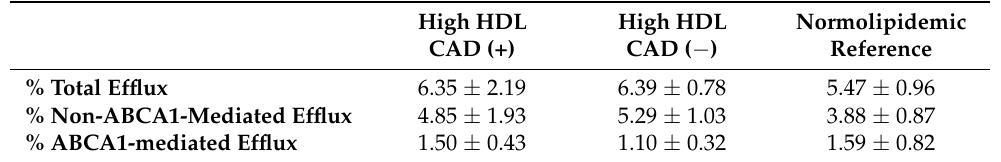
Table 3. Cholesterol efflux capacity of PEG-precipitated plasma for subjects with high HDL-C with and without CAD and normolipidemic subjects. Values are presented as percentage cholesterol effluxed from J774 cells over 6 h. N = 6 for High HDL CAD ( − ) and normolipidemic groups, n = 5 for High HDL CAD (+). Data are displayed as mean ± SD. Differences among groups were determined using ANOVA followed by a Tukey-HSD post-hoc test.